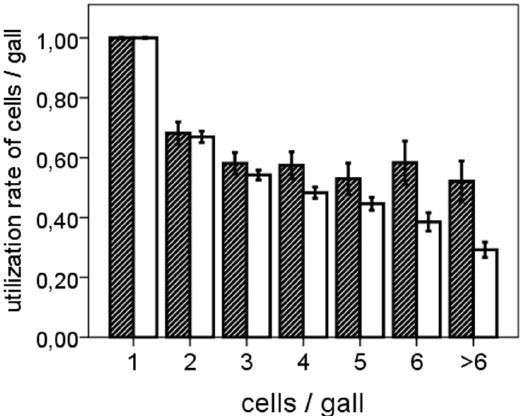
Figure 4. Average exploitation rate of galls attacked by E. serratulae (black) and/or E. robusta (white) as a function of gall size (cells / gall). Material: E. serratulae : 1407 galls; E. robusta: 1509